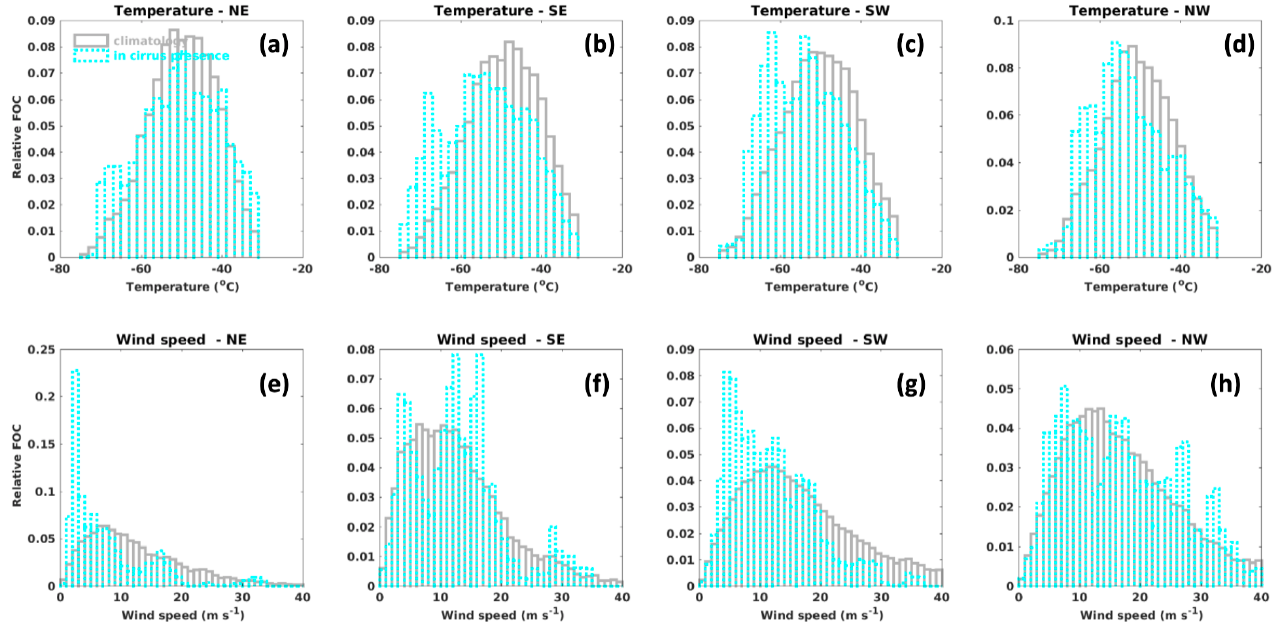
Figure 4. Relative FOC distribution of climatological meteorological conditions (gray) and conditions in the presence of cirrus (cyan). Temperature ( a – d ) and wind speed ( e – h ) within the monthly cirrus envelope (as given in Figure 2) are presented per wind sector, without any temporal restriction between the radiosonde and lidar measurements.